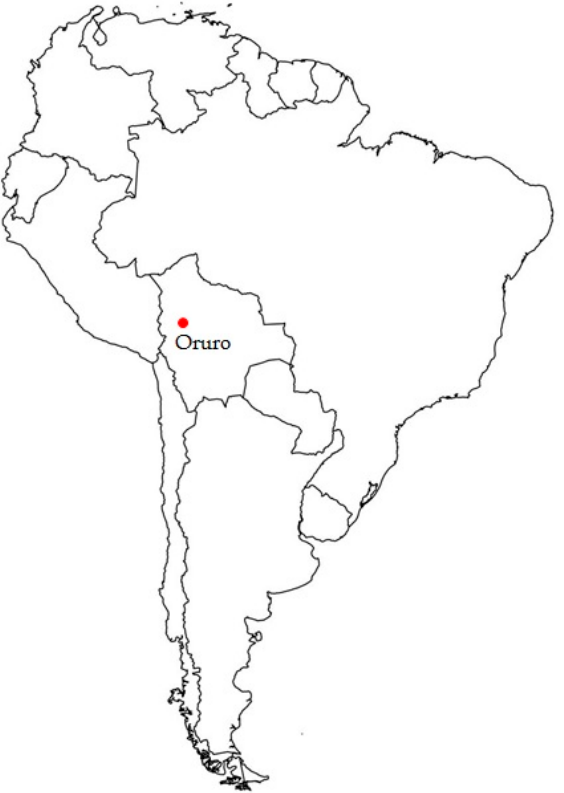
Figure 1. Own elaboration from data obtained from pixabay [10]